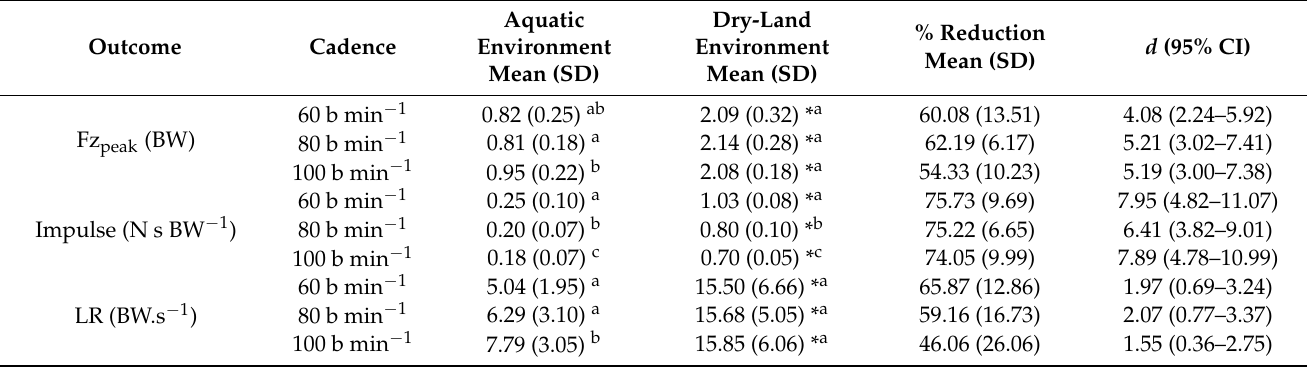
Table 2. Descriptive analysis of the peak vertical ground reaction force (Fz peak ), impulse and loading rate (LR) in the aquatic and dry-land environments during the performance of the stationary running exercise at three different cadences (60, 80 and 100 b min − 1 ) ( n =